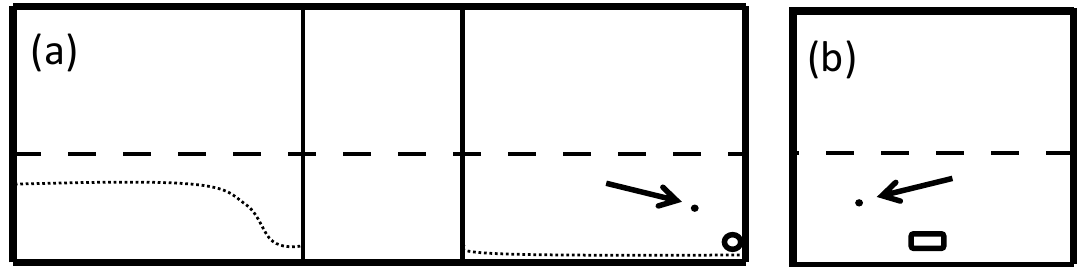
Figure 3. Schematic diagram of the aquaria set up, approximately to scale. ( a ) View of the long side of the aquarium; ( b ) view of the short side of the aquarium showing the position of the hole within the glass dividers. The dashed line represents the water level, the dotted line represents the height of sand within the two outer compartments, the circle shows the position of the refugia when present. The small black dots indicated by arrows provide an idea of the height of the fish relative to the aquaria.